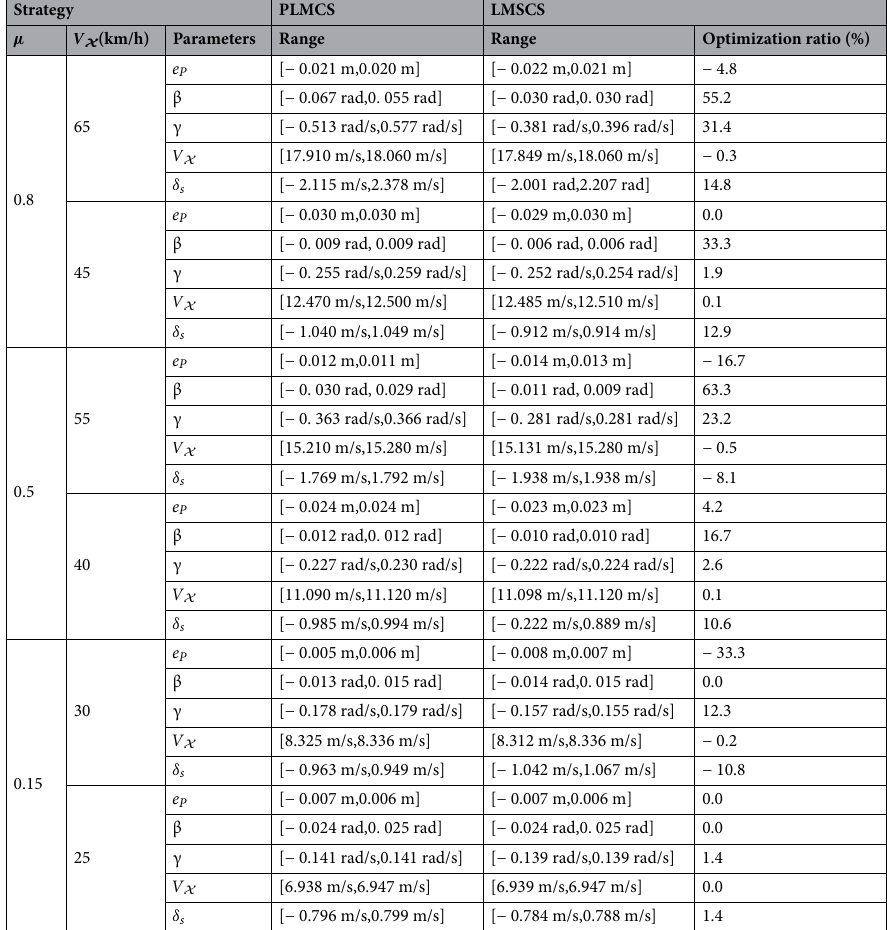
Table 3. Summary of DDAV double line driving simulation